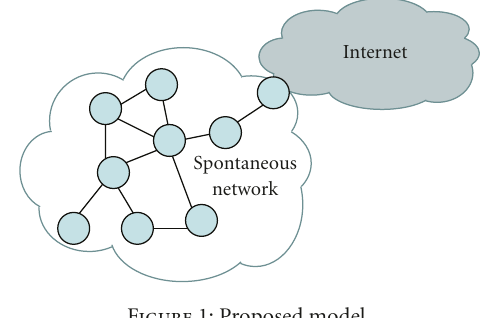
Figure 1: Proposed